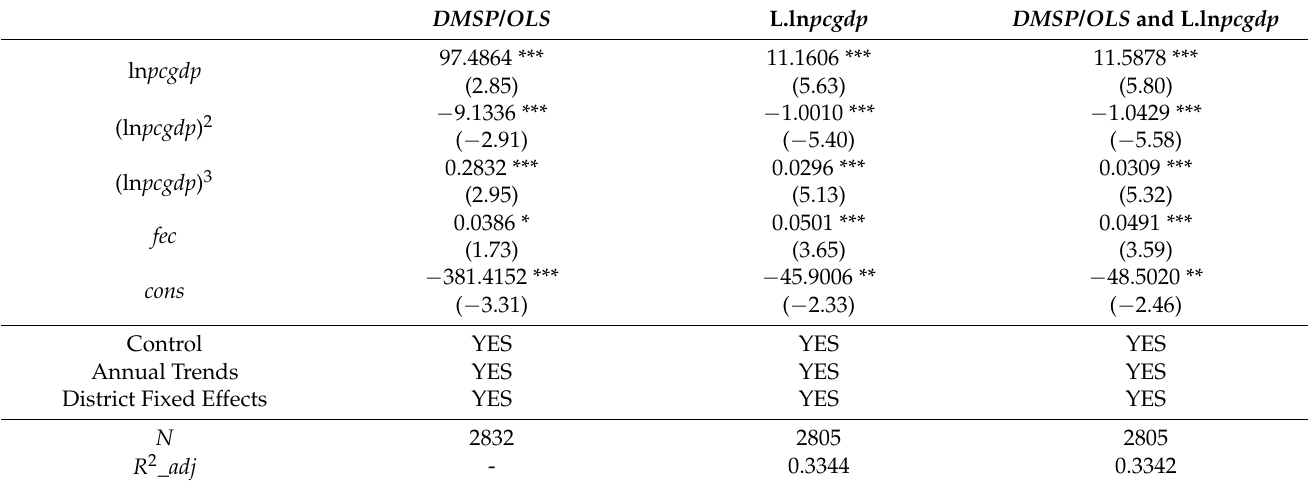
Table 4. Empirical results of endogenous analysis of the relationship between economic development and ecological